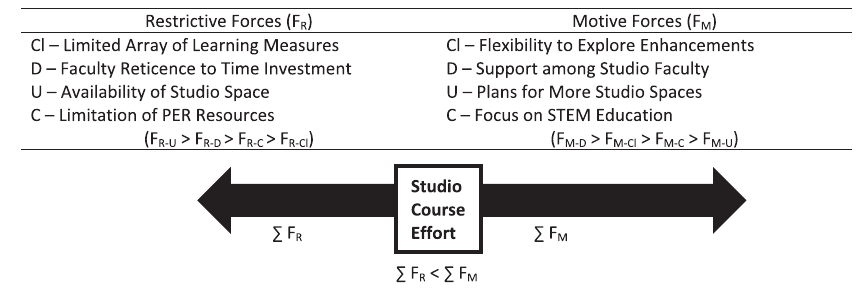
FIG. 6. Free body diagram for predicted forces in stage 4: Diffusion of the studio physics program (Cl—classroom; D—department; U—university;